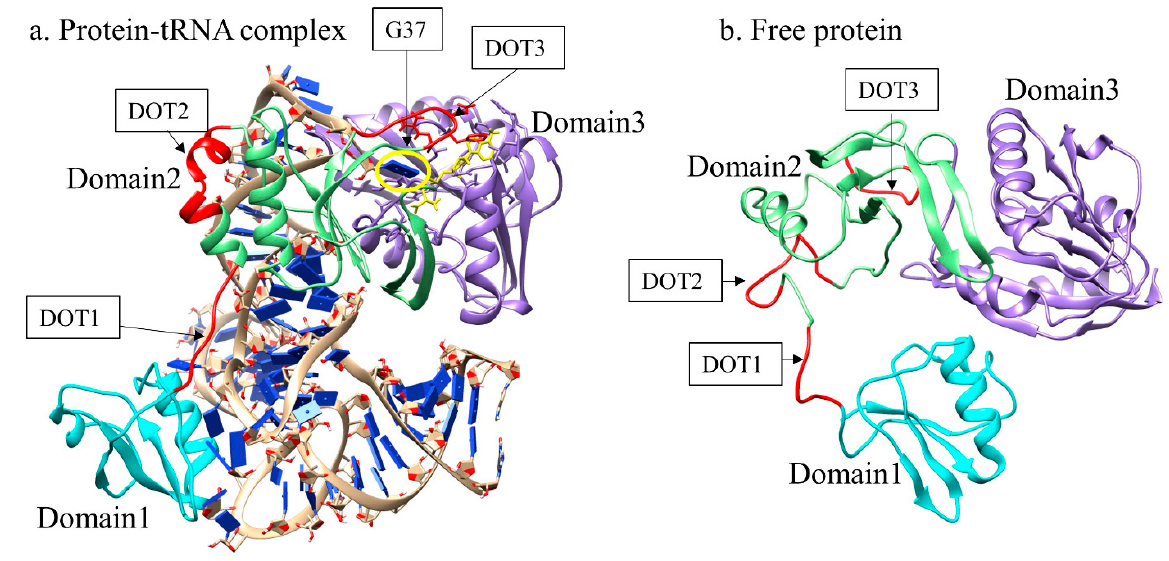
Figure 1. Archaeal tRNA methyltransferase enzyme in ( a ) complex form and ( b ) free protein. The domain 1 (D1), domain 2 (D2), and domain 3 (D3) are shown in cyan, green, and purple colours, respectively. The disorder-to-order transition (DOT) regions are highlighted with red colour, and G37 nucleotide is shown in the yellow oval.